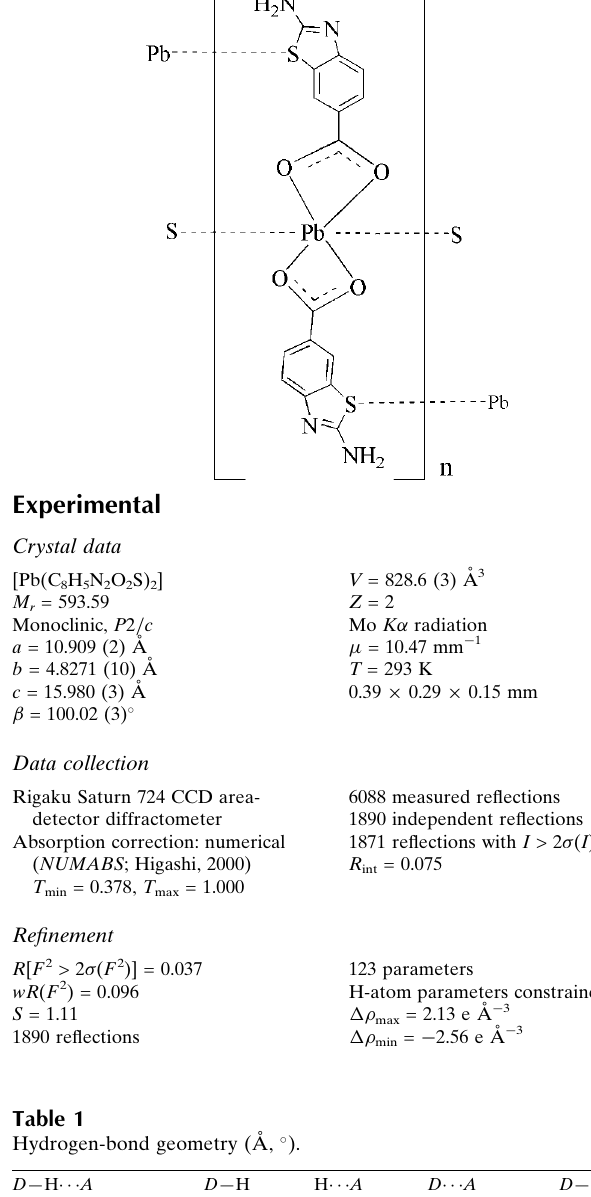
Hydrogen-bond geometry (A˚ , (cid:3)